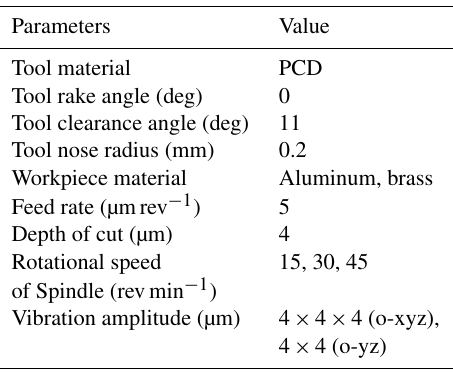
Table 1. Machining conditions.